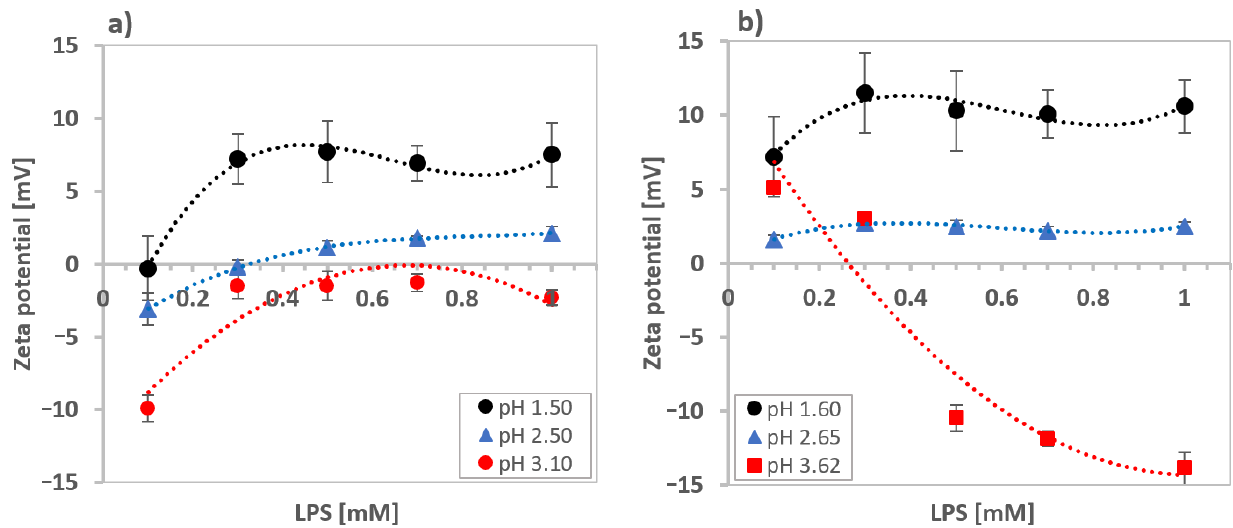
Figure 8. The zeta potential of ( a ) As waste in the presence of lipopolysaccharides (LPS) and ( b ) scorodite in the presence of LPS.